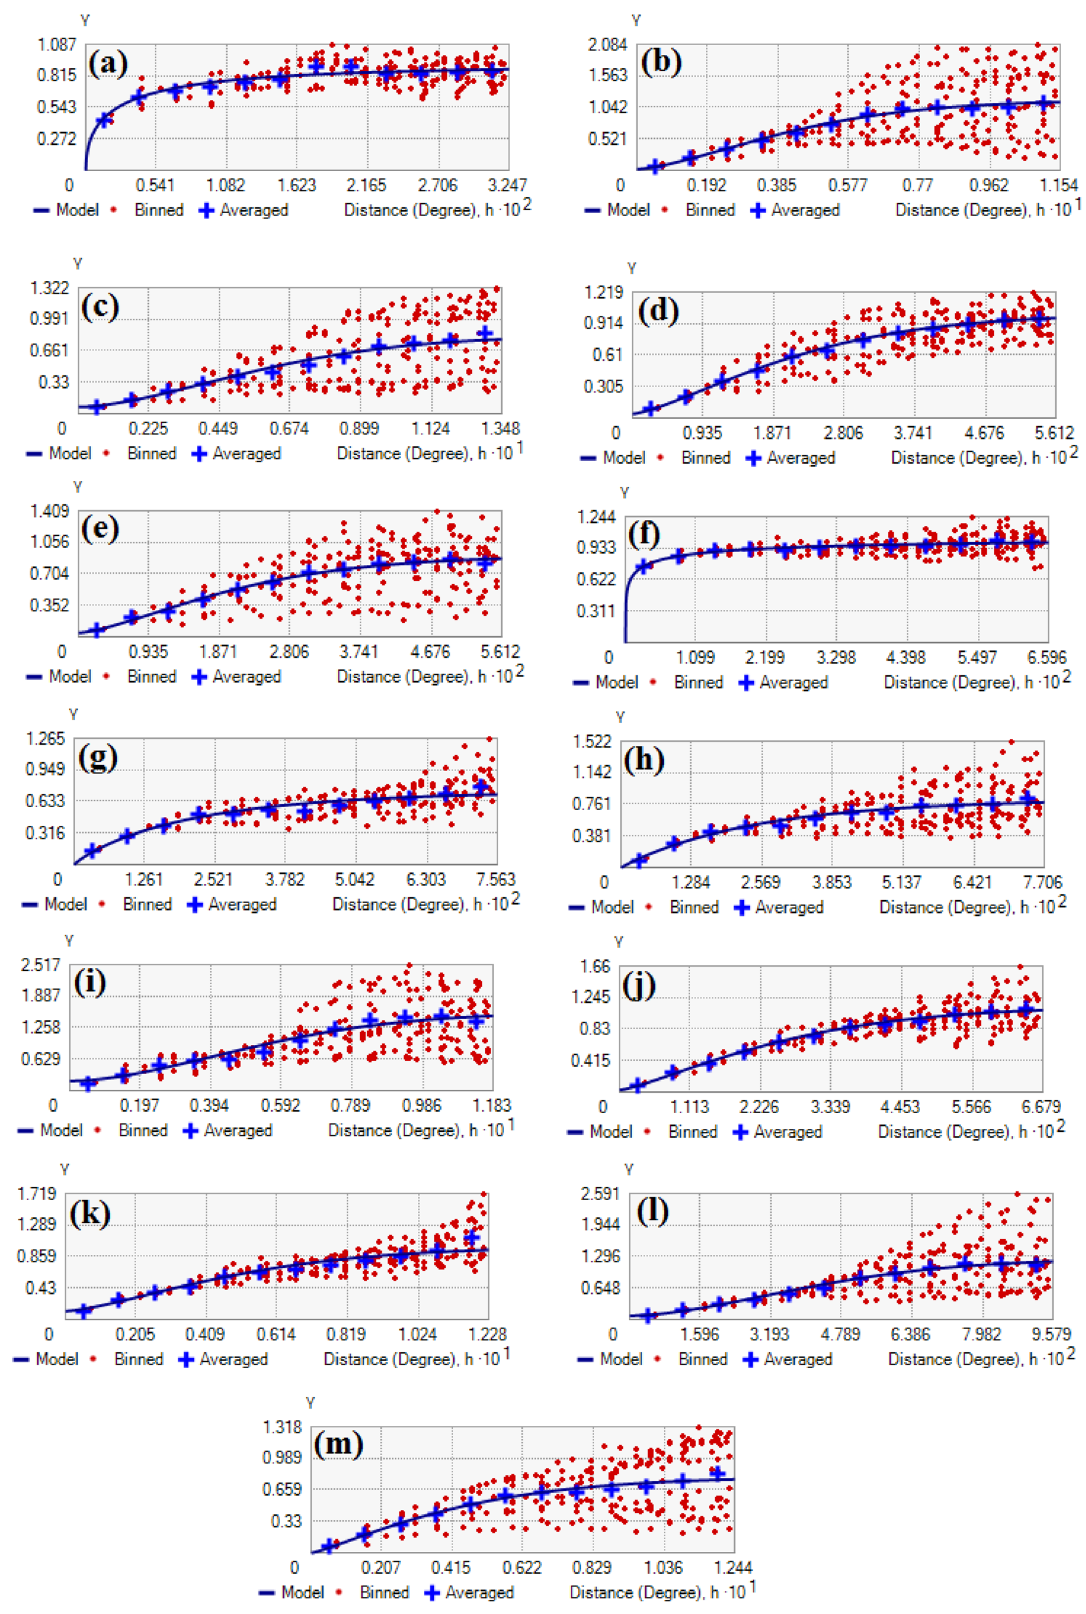
Figure 5. Result of semivariogram. ( a ) Distance to street, ( b ) Pressure, ( c ) Wind speed, ( d ) Humidity, ( e ) Temperature, ( f ) Distance to park, ( g ) PM 2.5, ( h ) PM 10, ( i ) SO 2 , ( j ) NO 2 , ( k ) CO, ( l ) O 3 , and ( m ) Rainfall. This map was generated using the tool of ArcGIS 10.3 (ESRI, Redlands, CA, USA,